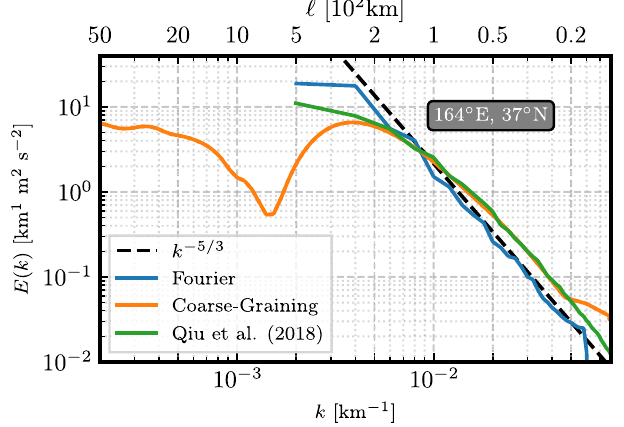
Fig. 4 | Energy spectra. Comparison of the fi ltering spectrum (orange), traditional Fourier spectrum (blue), and the Fourier spectrum from ref. 6 (green, data kindly provided by authors of ref. 6) for the 5°×5° box region centred at 164°E,37°N (roughly the Kuroshio extension).The dashed black line provides a reference for a − 5/3 slope. Note that the ℓ axis (top) is in 100 km.